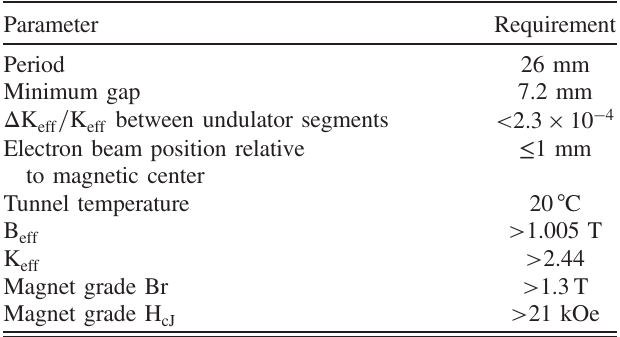
TABLE I. Requirements, per